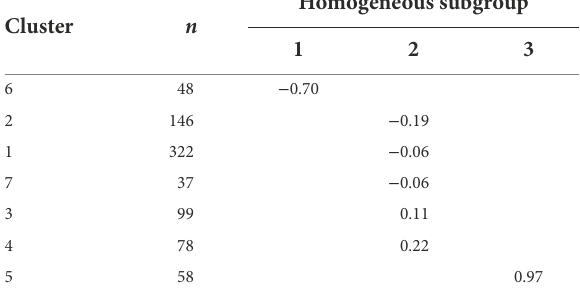
TABLE 4 Cluster effects on peer nomination for total influence on